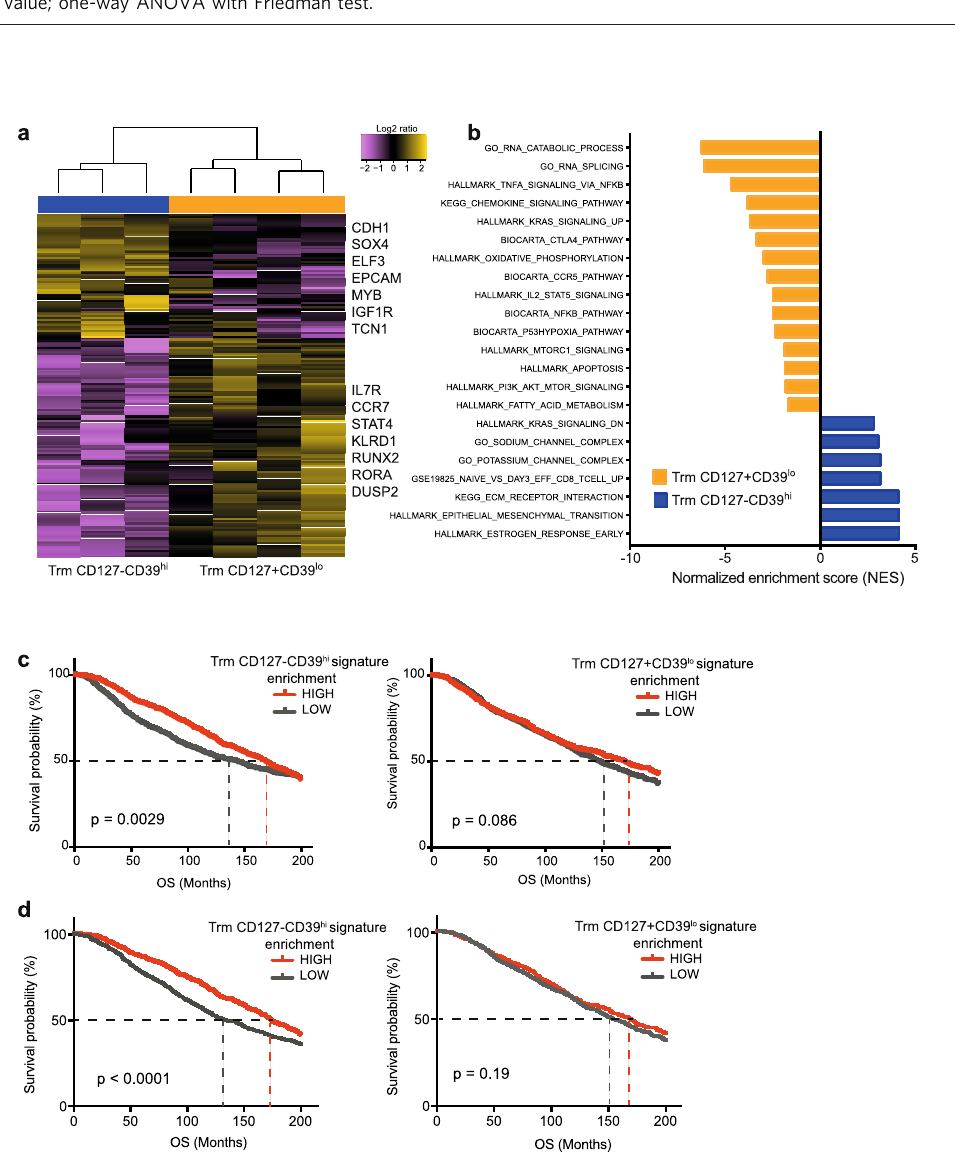
Fig. 2 CD8 + Trm cells are phenotypically and functionally heterogeneous in BC. a UMAP representation of the relative expression of selected markers analyzed by fl ow cytometry by manually gated CD8 + CD69 + CD103 + Trm cells concatenated from tumor samples ( n = 49 biologically independent samples). The gray area refers to the total CD8 + T-cell subpopulation. b Mean ± SEM summary of the MFI of different activation, coinhibitory and costimulatory markers by CD127 + CD39 lo , CD127 − CD39 lo , and CD127 − CD39 hi Trm subpopulations from tumor samples ( n = 54 biologically independent samples), as de fi ned by fl ow cytometry. Numbers indicate the exact p values; one-way ANOVA with Friedman test. c Bar plots showing the frequency depicted as mean ± SEM of CD127 + CD39 lo , CD127 − CD39 lo , and CD127 − CD39 hi in CD8 + cells among different tissue compartments (tumor, normal breast, and peripheral blood; n = 54 biologically independent samples). Numbers indicate the exact p values for tumor vs. peripheral blood or normal tissue samples; one-way ANOVA with Friedman test. d Mean± SEM summary of the frequency of CD127 − CD39 hi Trm among total CD8 + cells in metastatic (mts; n = 12 biologically independent samples) and nonmetastatic (non-mts; n = 7 biologically independent samples) lymph nodes (LN). Numbers indicate the exact p value; Mann – Whitney test. Data were obtained in one experiment. e Flow cytometry plots from a representative patient showing the production of CD107a, IL-2, TNF, and IFN- γ by BC tumor-in fi ltrating CD8 + Trm subsets in response to PMA/ionomycin stimulation (STIM) in vitro. Numbers in the histograms indicate the percentage of positive cells identi fi ed by the gates. UNSTIM unstimulated control. f Mean ± SEM summary of the frequency of effector molecules expression from e ( n = 6 biologically independent samples; performed in two independent experiments). Numbers indicate the exact p value; one-way ANOVA with Friedman test.